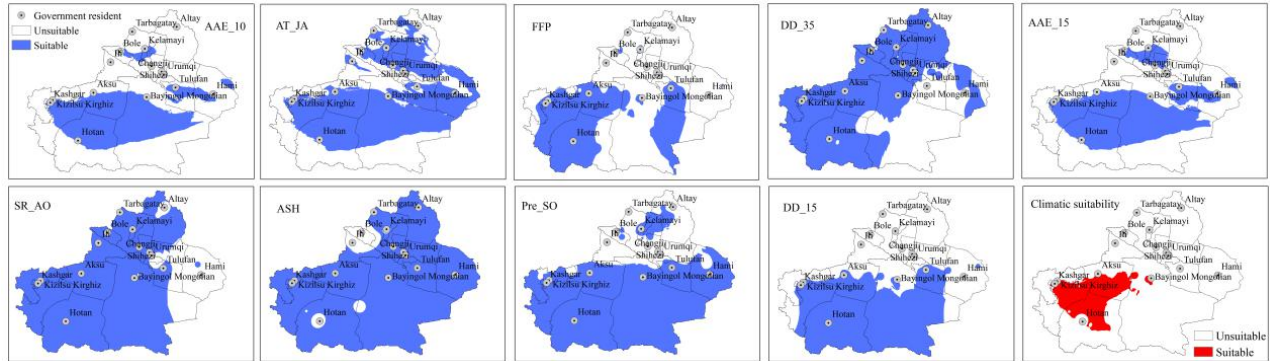
Figure 5. Suitable climate area for early–medium-maturing cotton seed production, AAE_10, the active accumulated temperature equal to or greater than 10 ◦ C; AT_JA, the average temperature in July and August; FFP, the frost-free period; DD_35, the duration in days of temperature equal to or greater than 35 ◦ C; AAE_15, the active accumulated temperature greater than 15 ◦ C; SR_AO, the sunshine rate from April to October; ASH, annual sunshine hours; Pre_SO, precipitation from September to October; DD_15, the duration in days of temperature equal to or greater than 15 ◦